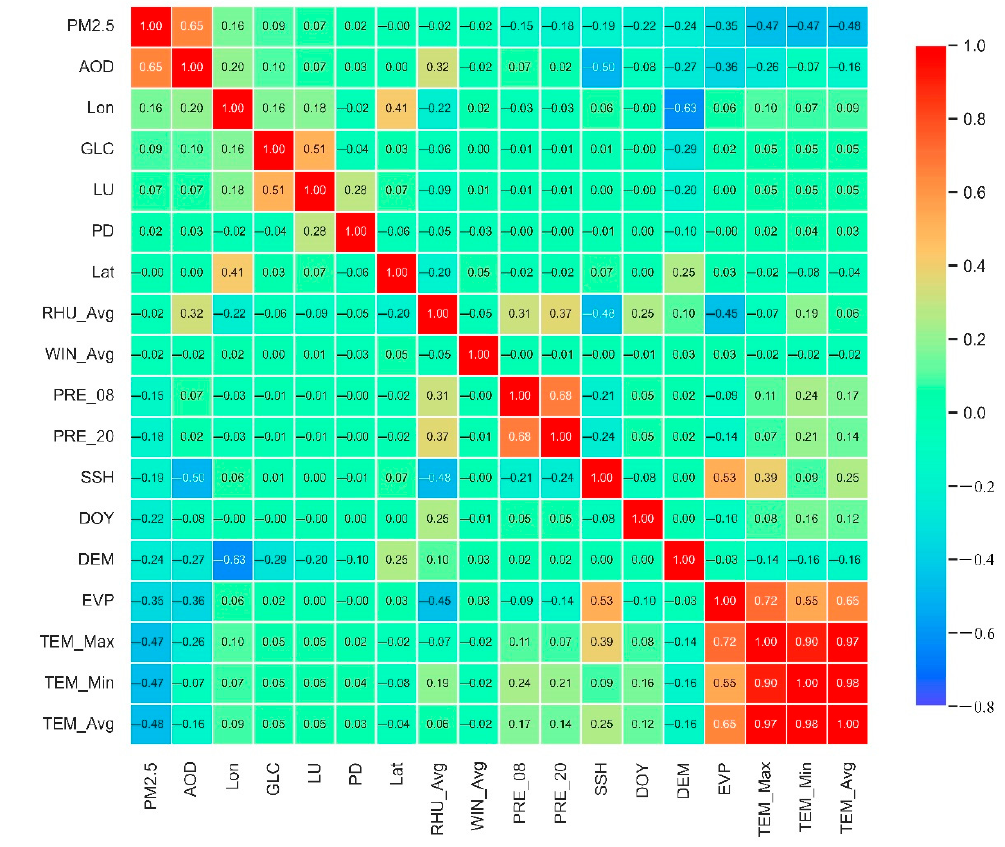
Figure 2. The correlation coefficient matrix between PM 2.5 Observation and each variable in GUA.